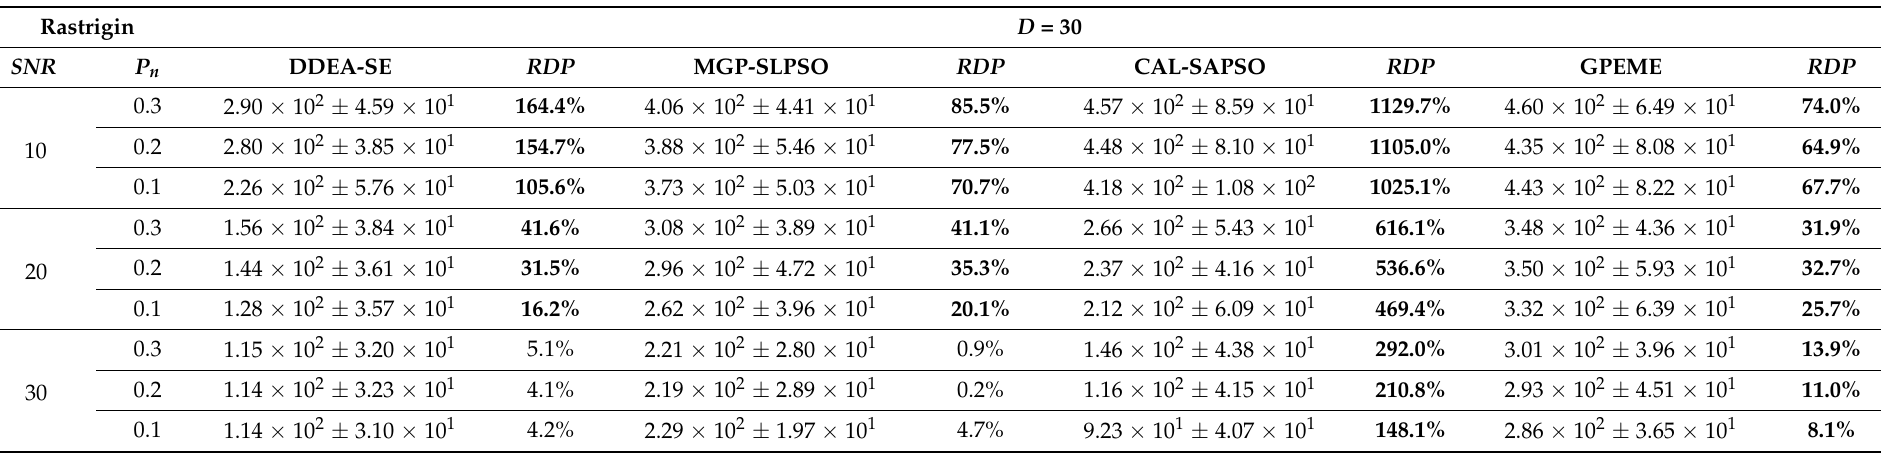
Table A10. Experimental results (with standard deviation) and RDP of DDEAs on 30-dimensional Rastrigin